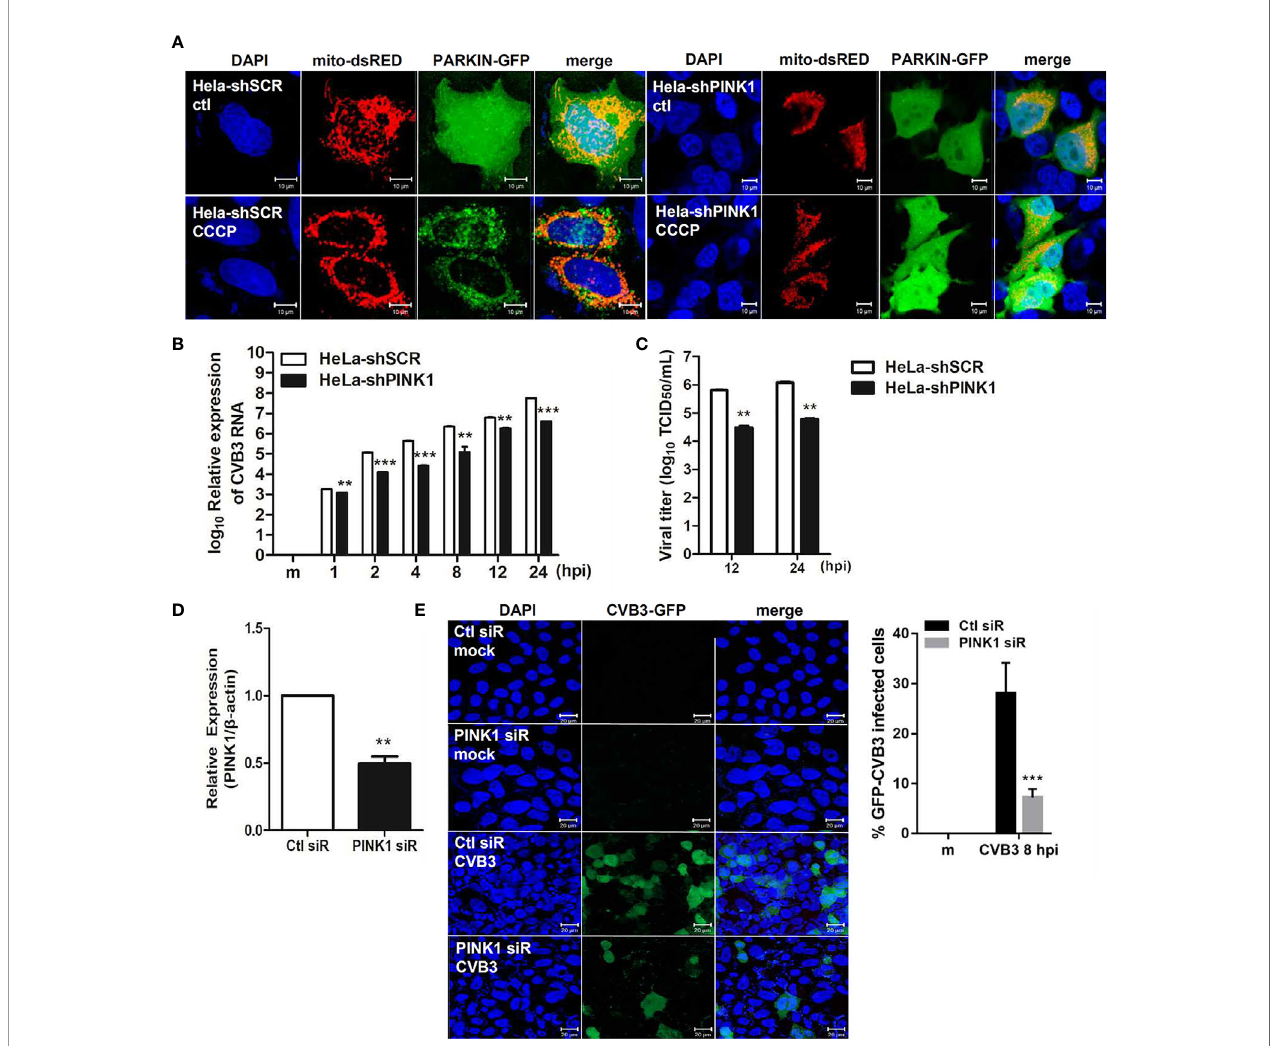
FIGURE 5 | PINK1 is important for CVB3 replication (A) HeLa-shSCR and HeLa-shPINK1 cells were treated with CCCP for 2 h. Representative images illustrating PINK1-dependent changes in Parkin-GFP fl uorescence from diffuse to punctate form. (Scale bar=10 m m). (B) Quantitative realtime PCR results indicating the expression levels of CVB3 vRNA. **p < 0.01; ***p < 0.001 vs . HeLa-shSCR-expressing cells. (C) Supernatants were collected from HeLa-shSCR and HeLa-shPINK1 cells infected with CVB3 at an MOI of 1 for various time points. Viral titers were determined by TCID50 assay and expressed as TCID50/mL. Results represent mean ± SD of